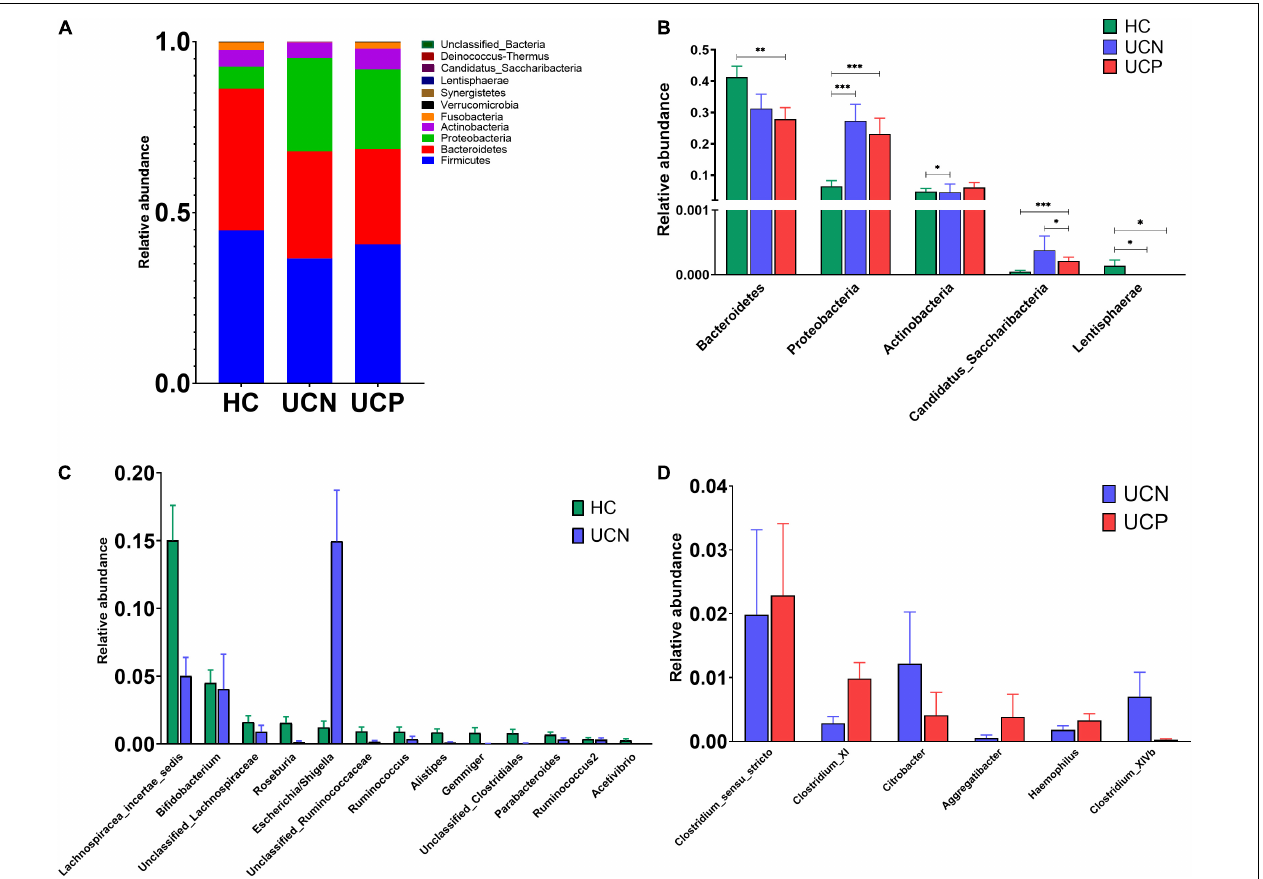
FIGURE 2 | (A) The structure of the gut microbiota at the phylum level among the three groups. (B) The significantly different taxa at the phylum level among the three groups. ∗ P < 0.05, ∗∗ P < 0.01, ∗∗∗ P < 0.001. (C) The significantly different taxa at the genus level between the HC and UCN groups. (D) The significantly different taxa at the genus level between the UCN and UCP groups. HC, healthy control group; UCN, ulcerative colitis without negative Clostridioides difficile test results; UCP, ulcerative colitis with positive Clostridioides difficile